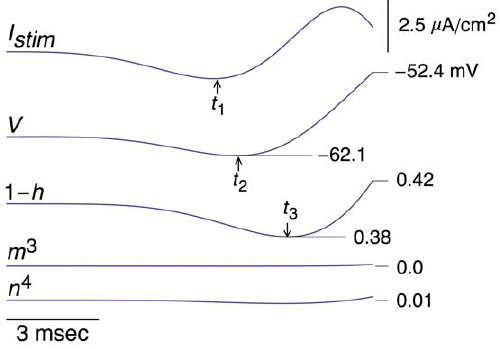
Figure 3. Same result as in Figure 2 with an emphasis on times of occurrence of the minima in I stim , V , and 1 2 h ; t 1 , t 2 , and t 3 , respectively. Relatively little change occurs in m 3 and n 4 , as indicated in the bottom two tracings. These results are on the same scales as the